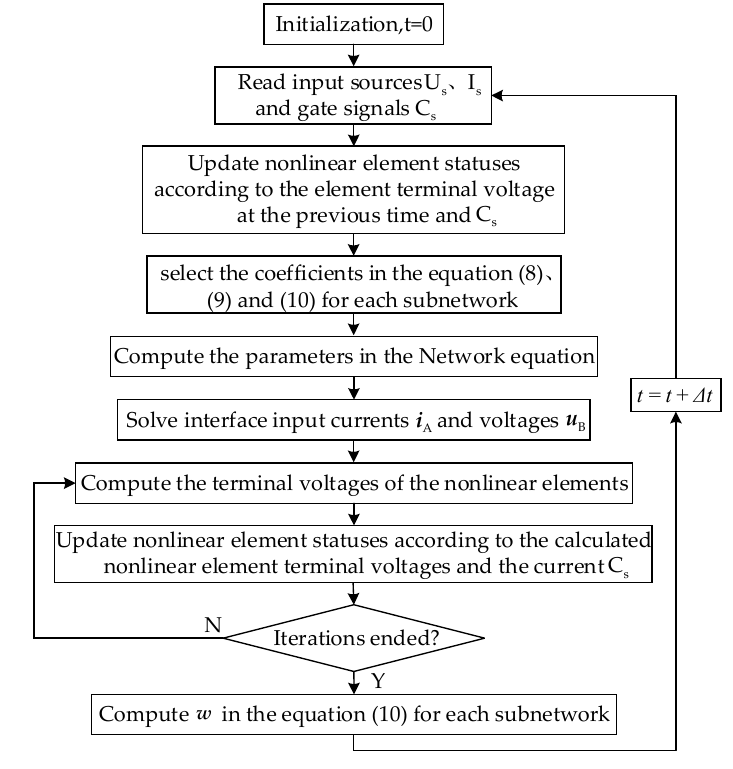
Figure 9. Flowchart describing the simulation algorithm.